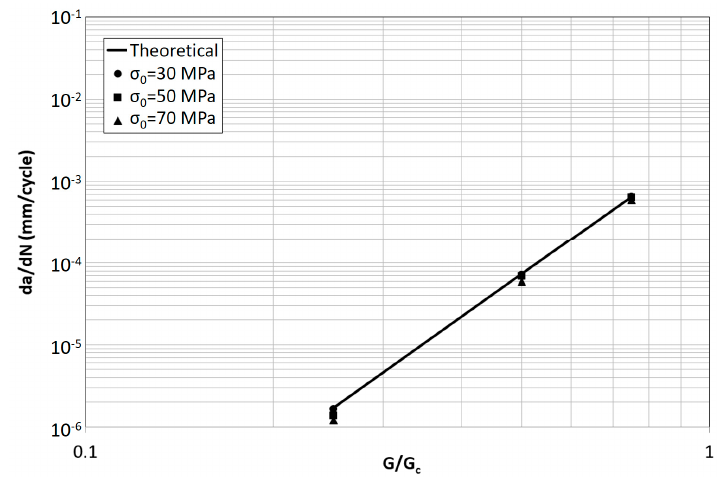
Figure 12. FCG rate as a function of G/G c for different values of σ 0 (K 0 = 10 5 MPa/mm).